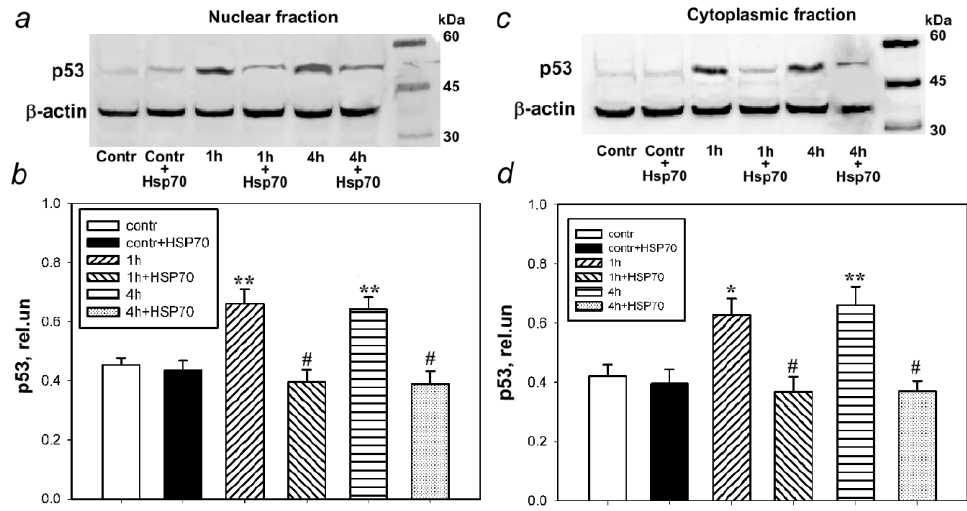
Figure 3. Western blot analysis of the p53 levels in the nuclear and cytoplasmic fractions of bilaterally axotomized crayfish ventral nerve cord (VNC) ganglia under normal conditions (contr) and in the presence of exogenous Hsp70 (contr + Hsp70), at 1 (1 h) and 4 (4 h) hours after axotomy, as well as 1 (1 h + Hsp70) and 4 h (4 h + Hsp70) after axotomy in the presence of eHsp70 (600 nM). ( a , b ) The level of p53 in the VNC nuclear fraction. ( c , d ) The level of p53 in the VNC cytoplasmic fraction. N = 8. * p < 0.05 and ** p < 0.01 compared to the control group. # p < 0.05 compared to the axotomy group (1 h and 4 h). A significant decrease can be seen in the level of p53 in both the nuclear and cytoplasmic fractions after the addition of exogenous